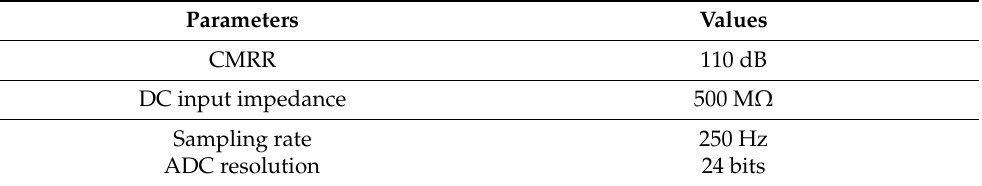
Table 2. Specifications of OpenBCI Cyton